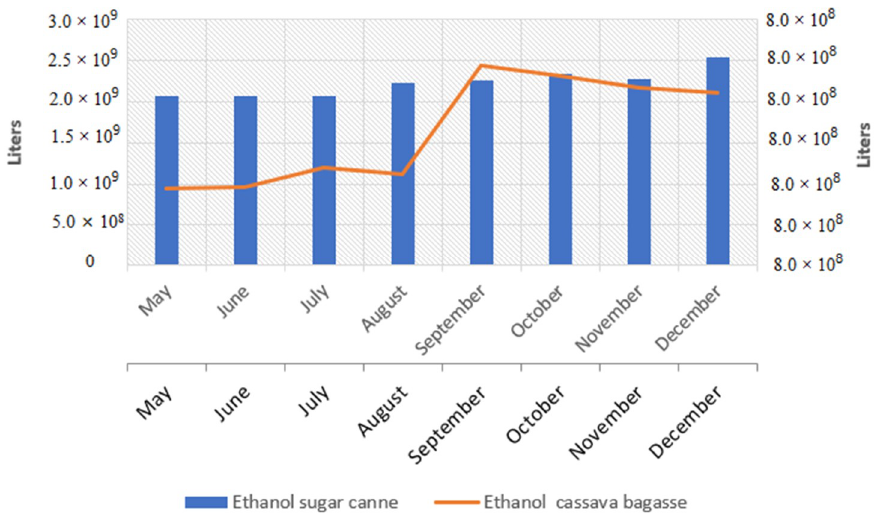
Figure 3. Comparison of the production of first and second generation etanol; source: UNICA—Union of Producers of Sugar Cane, 2018.